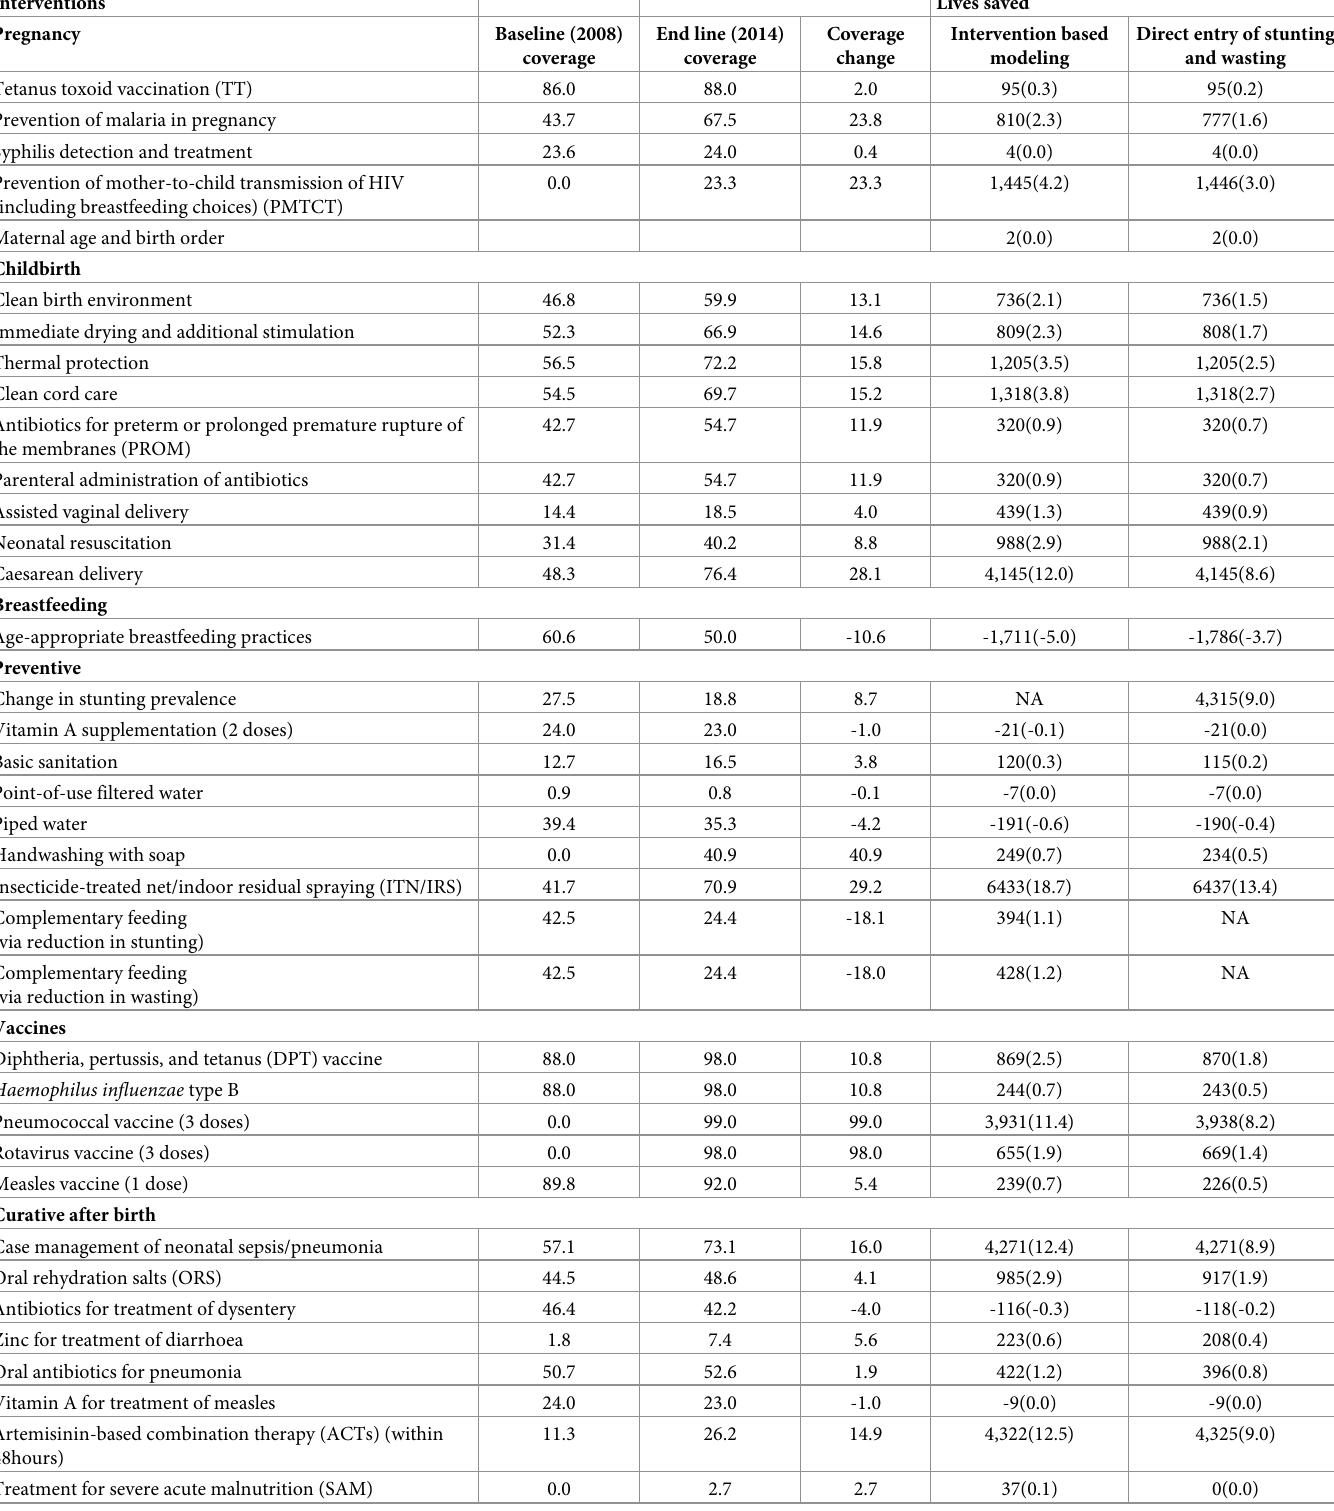
Table 1. Additional child lives saved and mortality reduction by intervention between 2008 and 2014 among children 0–59 months.